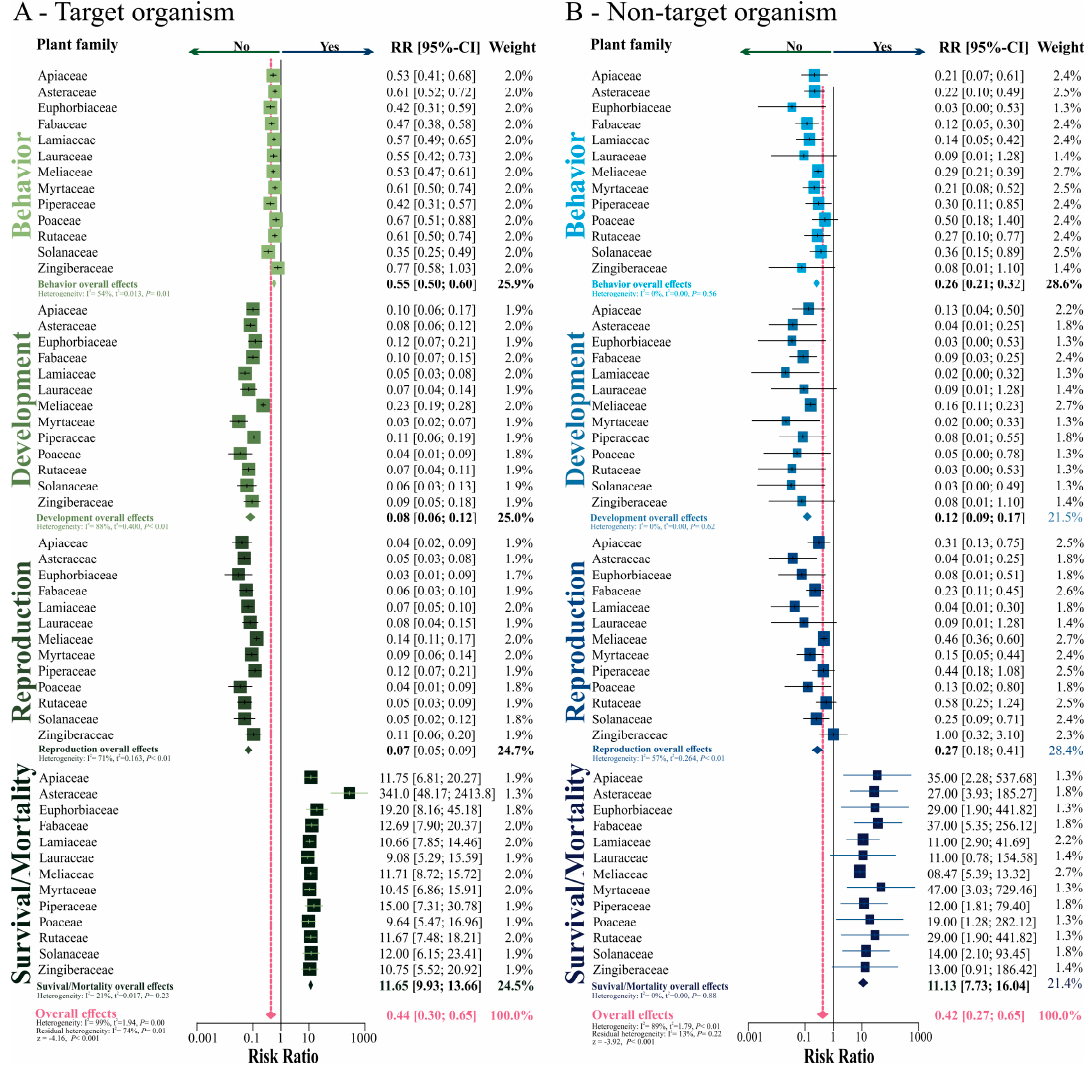
Figure 6. Risk ratio (or probability) of a biological parameter as survival / mortality, development, reproduction and / or behavior in ( A ) target organism, and in ( B ) non-target organism tested experimentally in the di ff erent families of